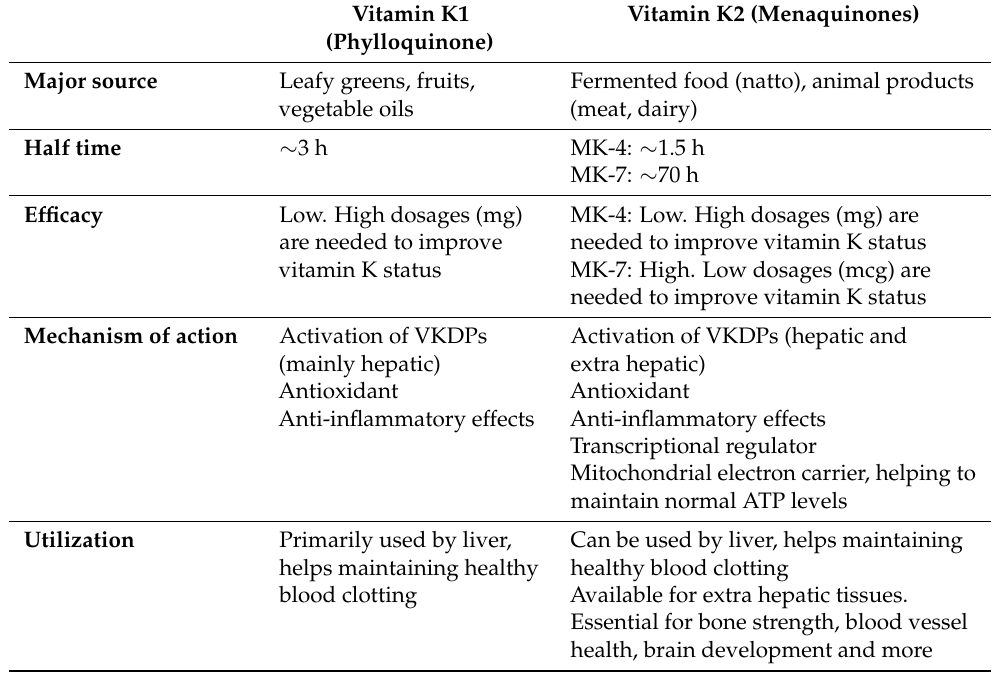
Table 1. Distinguishing Between Vitamins K1 and